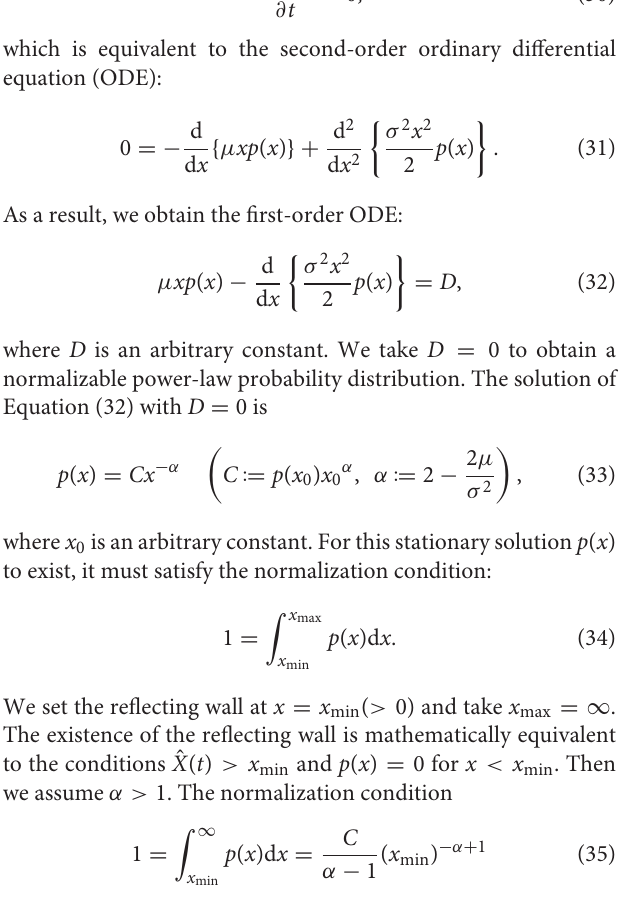
2 and U (0) 4 and the Simon model equivalent to = =